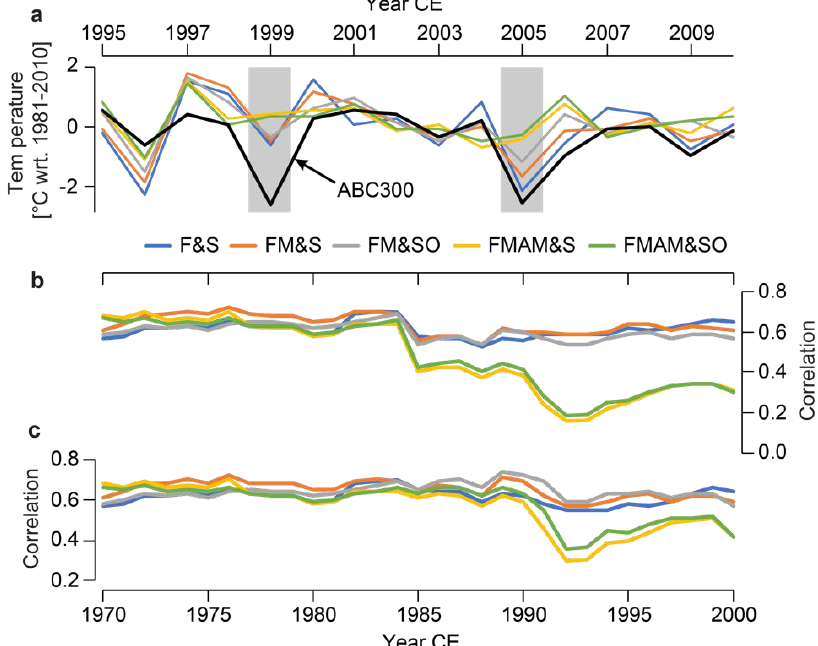
Figure 8. Effects of non-coherent extremes. ( a ) The scaled ABC300 chronology (black curve) shown together with the seasonal temperature means of five regional stations (colored curves). ( b ) Thirty-year running correlations between the ABC300 chronology and seasonal temperatures. ( c ) Same as in ( b ), but without the 1999 and 2005 instrumental and proxy data.